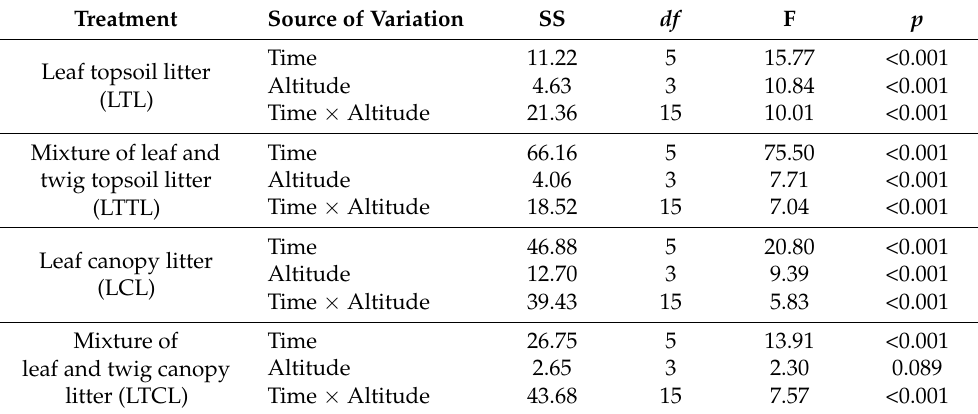
Table 1. Two-way ANOVA of the effects of altitude and decomposition time on NSC content in Chinese fir topsoil litter and canopy litter.